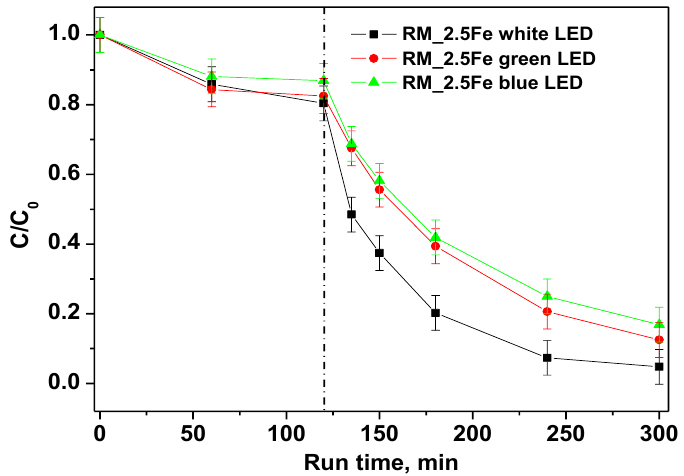
Figure 10. Photocatalytic discoloration of CV aqueous solution with the RM_2.5Fe photocatalyst under white, green and blue light irradiation.